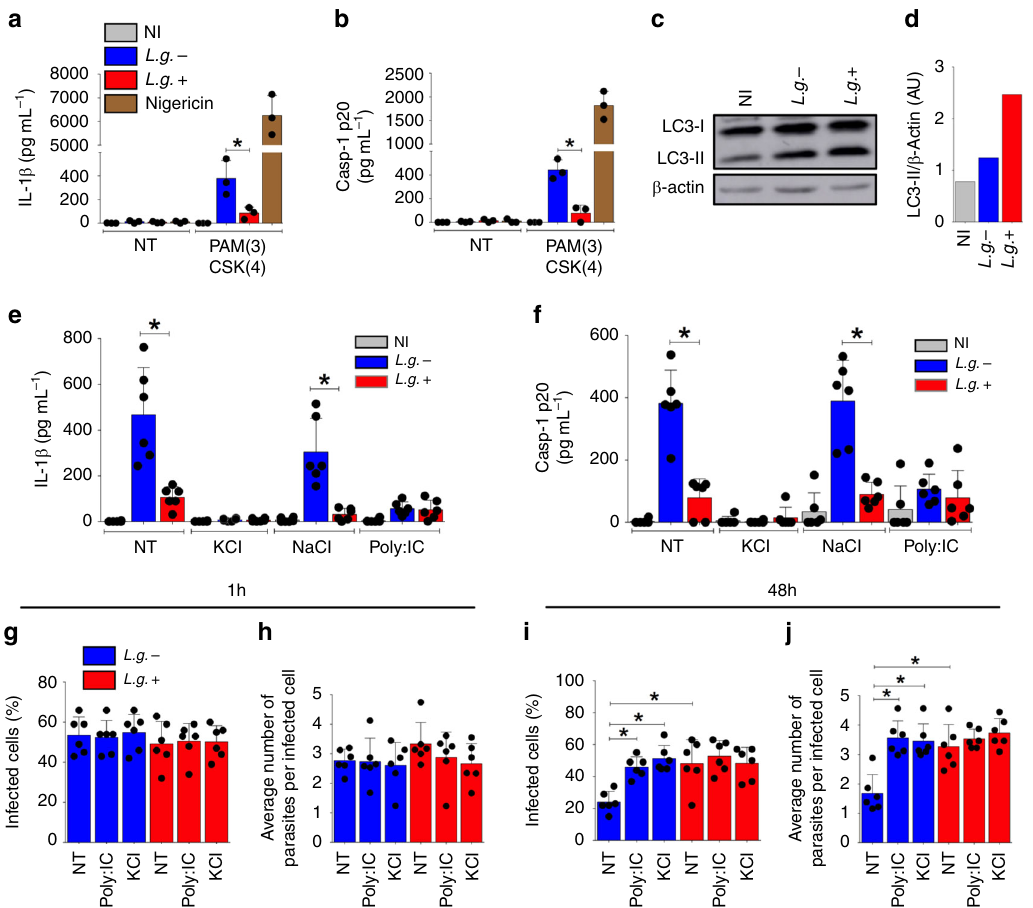
Fig. 9 LRV modulates NLRP3 in fl ammasome in human macrophages. Human monocyte-derived macrophages were left unprimed or primed with PAM(3) CSK(4) (300 ng mL − 1 ) for 4 h, and then infected with L.g. − or L.g . + . The levels of IL-1 β ( a ) and Casp1 p20 ( b ) were determined in cell-free supernatants by ELISA. c Human macrophages from three different donors were mixed, plated and left non-infected (NI) or infected with L.g. − and L.g . + . The expression of LC3-I and LC3-II was measured by western blotting. d Quanti fi cation of LC3-II was performed by dividing LC3-II densitometry values provided by ImageJ per β -actin (arbitrary units, AU). e , f PAM(3)CSK(4)-primed human macrophages were left untreated (NT) or treated with Poly:IC (5 μ g/mL), NaCl (100 mM), or KCl (100 mM) at the moment of infection. The levels of IL-1 β ( e ) and Casp1 p20 ( f ) were determined in cell-free supernatants by ELISA. g – j Unprimed human macrophages were treated as described above to evaluate parasite killing by Panotico Giemsa . The percentage of infected cells ( g , i ) and the average number of parasites per infected cell ( h , j ) is shown at 1 and 48 h after infection. The results are shown as mean ± SD. Statistical analysis was performed by unpaired Student ’ s t test, while P < 0.05 (*) was considered statistically signi fi cant. One representative of at least two independent experiments performed is shown. Each dot in graphs represents macrophages from an individual donor. The results are demonstrated as